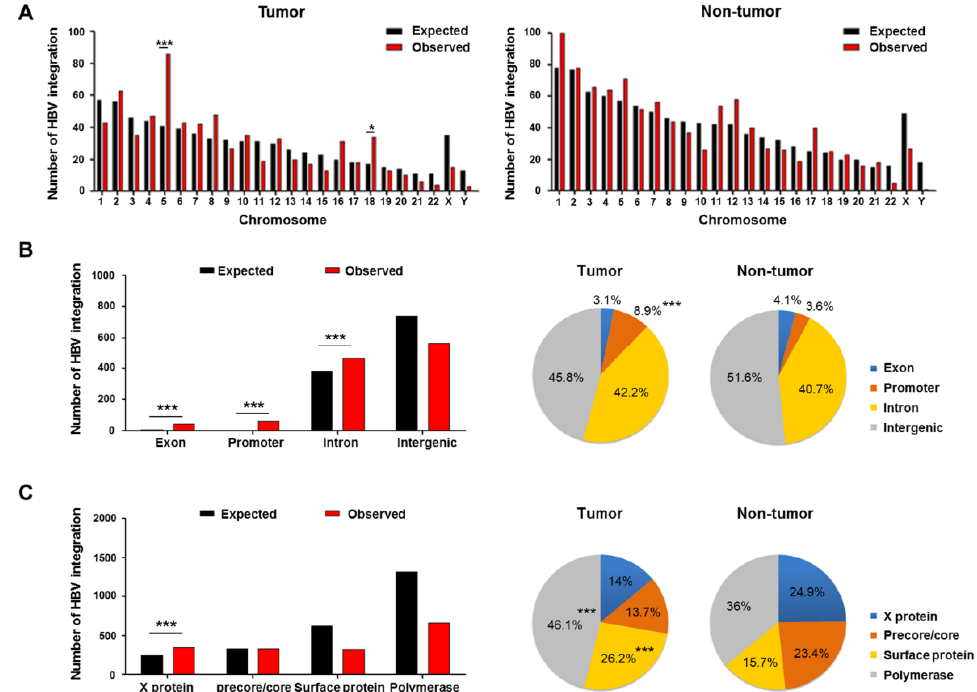
Figure 1. ( A ) Distribution of hepatitis B virus (HBV) integration breakpoints across all human chromosomes. ( B ) The proportion of HBV integration sites in genic and intergenic areas in paired tumor and non-tumor tissues. ( C ) HBV integration sites in the HBV genome. HBV integration breakpoints were counted by allowing overlaps between the four open reading frames. p -value (binomial distribution): *** < 0.001